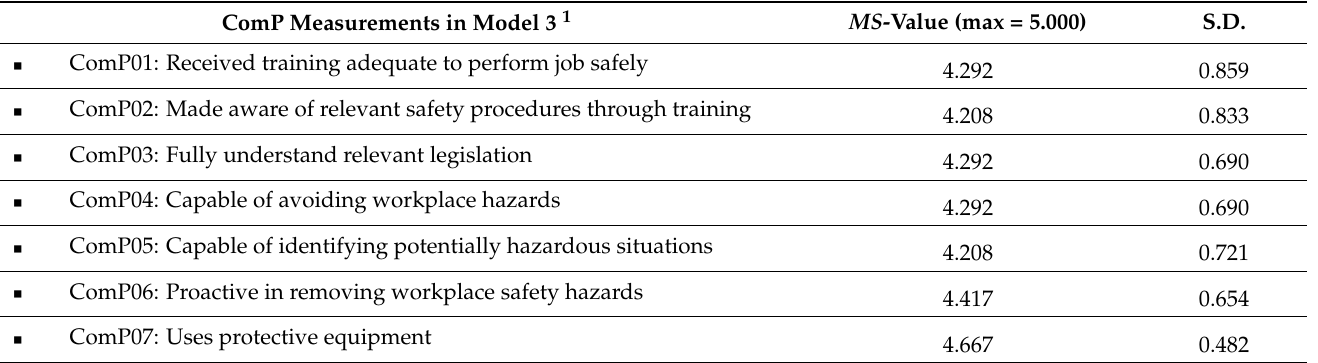
Table 8. Importance of ComP Measurements in Model 3 (Adopted from Mohamed, 2002 [8]). Table 7. Importance of ComP Measurement in Model 2 (Adopted from Mohamed, 2002 [8]). ComP Measurements in Model 3 1 Table 7. Importance of ComP Measurement in Model 2 (Adopted from Mohamed, 2002 [8]). ComP Measurements in Model 2 1 Table 7. Importance of ComP Measurement in Model 2 (Adopted from Mohamed, 2002 [8]). ComP Measurements in Model 2 1 Table 7. Importance of ComP Measurement in Model 2 (Adopted from Mohamed, 2002 [8]). ComP Measurements in Model 2 1 Table 7. Importance of ComP Measurement in Model 2 (Adopted from Mohamed, 2002 [8]). ComP Measurements in Model 2 1 Table 7. Importance of ComP Measurement in Model 2 (Adopted from Mohamed, 2002 [8]). ComP Measurements in Model 2 1 Table 7. Importance of ComP Measurement in Model 2 (Adopted from Mohamed, 2002